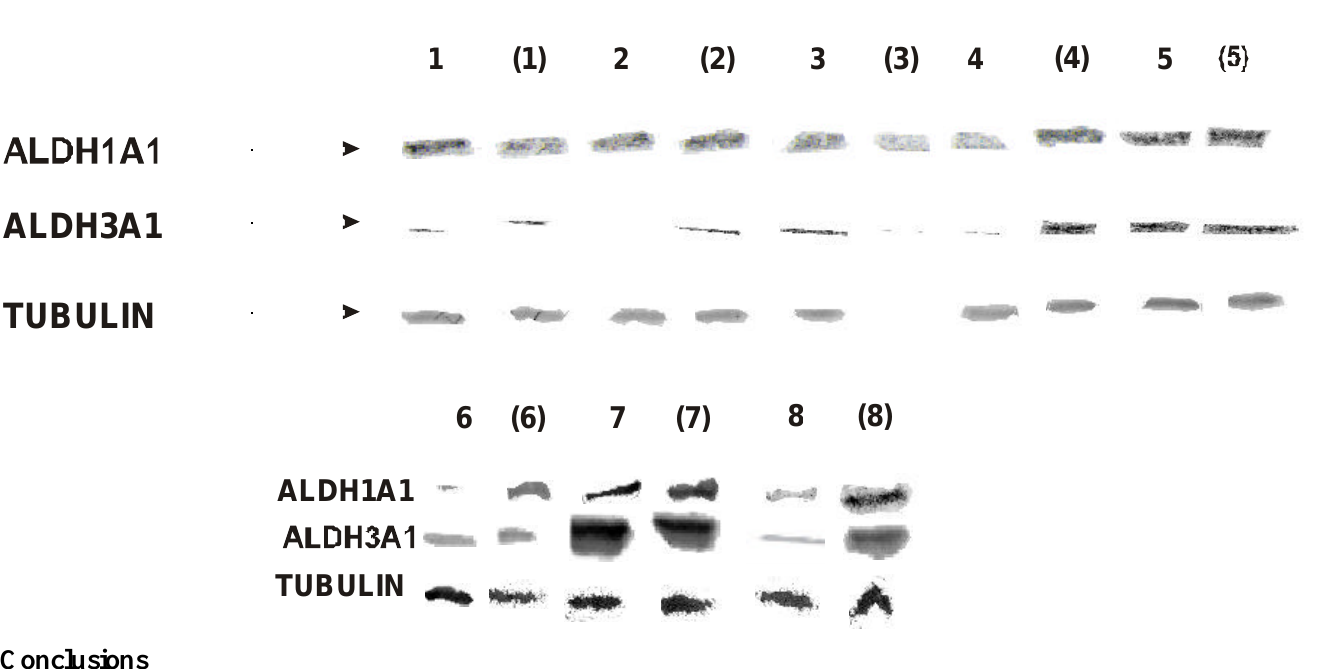
Figure 1. Western blot analysis - tumour samples and the surrounded tissue (in